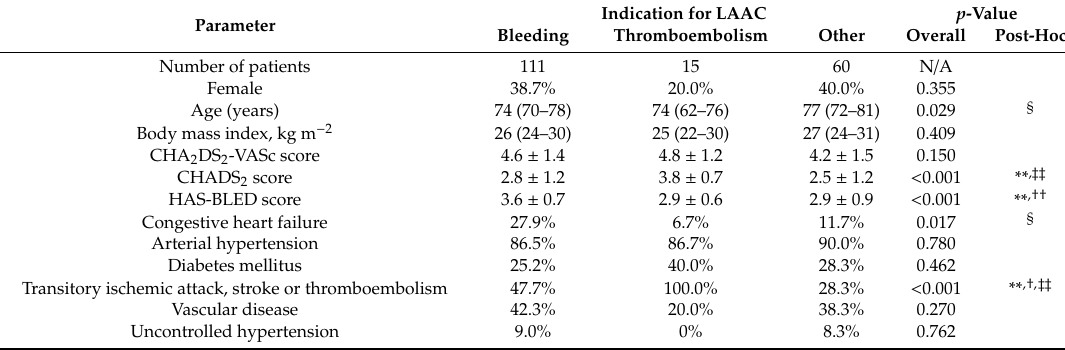
Figure 1. Study flowchart. LAAC: left atrial appendage closure. Table 1. Baseline characteristics of the treated patients, grouped by their indication for LAAC.